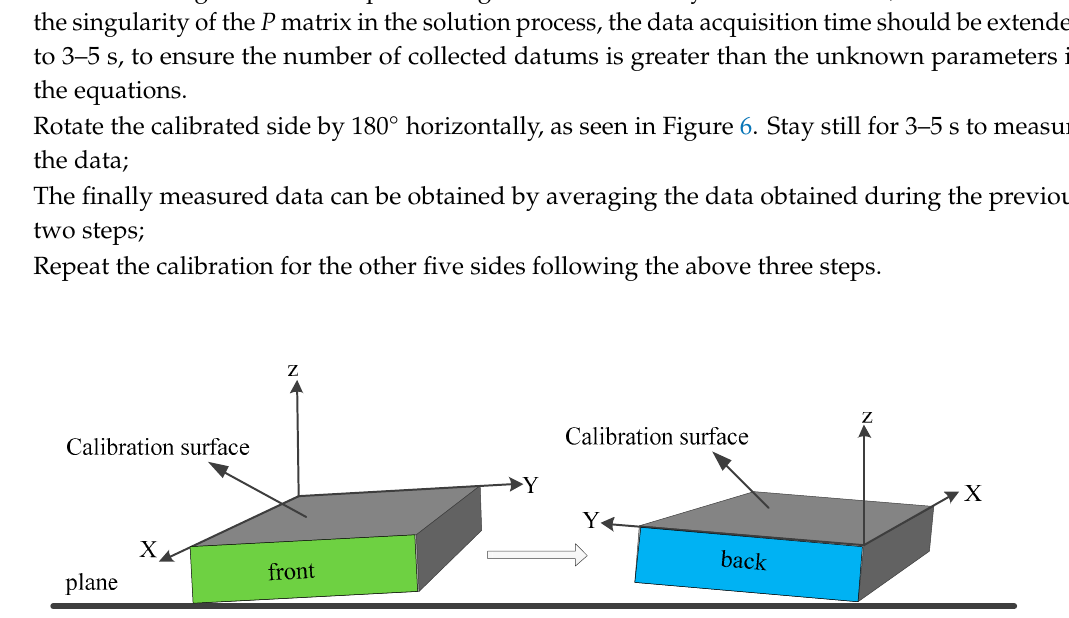
Figure 5. This is a schematic diagram of the deviation of the calibration surface from the direction of gravity’s acceleration.